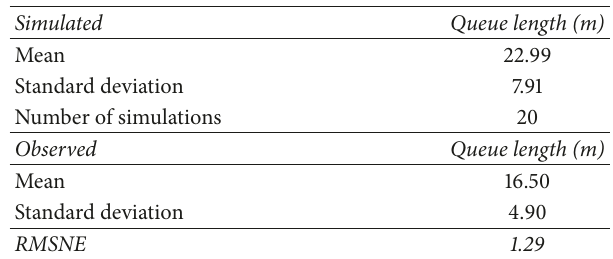
Table 9: Comparison between field-measured and simulated queue lengths in Scenario